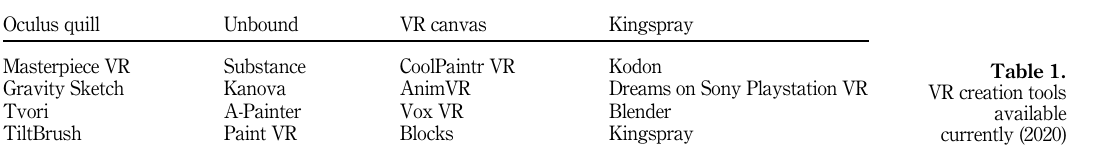
Table 1. VR creation